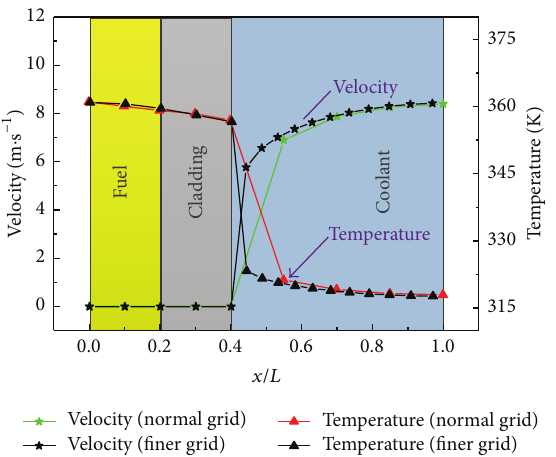
Figure 11: Velocity and temperature distribution.